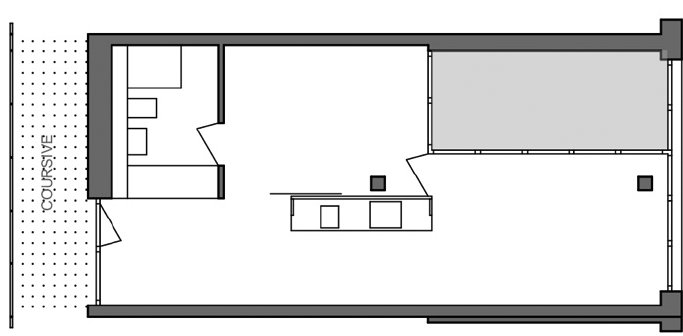
Figure 8. EMI Architekten, type MIN 1 of the Glattpark building (2013–2016), Opfikon, plan. Re-drawn by EPFL students for UE B architectural critic